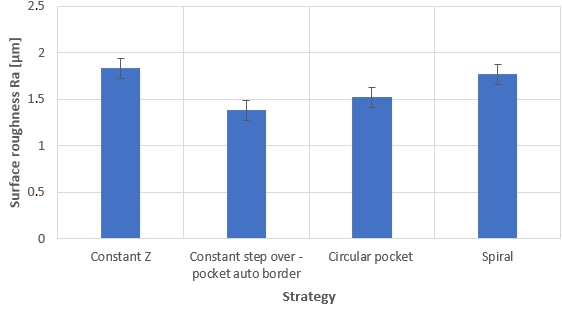
Figure 32. Comparison of roughness parameter Ra.